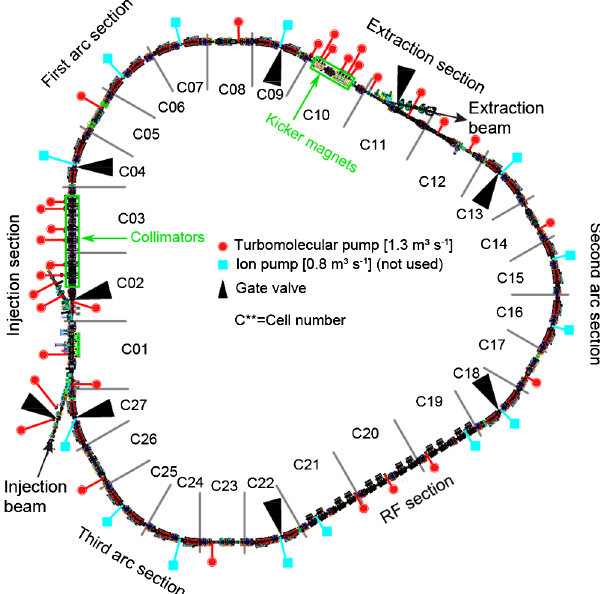
FIG. 1. Layout of the RCS vacuum system. The RCS consists of three straight sections and three arc sections, between which all-metal gate valves are installed. The beam line is divided into 27 cells for convenience. Vacuum gauges are not drawn in the figure. The ion pumps have not been used because of the intermittent outgassing problem (Fig. 4). The beam pipes and bellows are made of titanium. The beam pipes in the magnets are made of alumina ceramics, whose inner surface is coated by